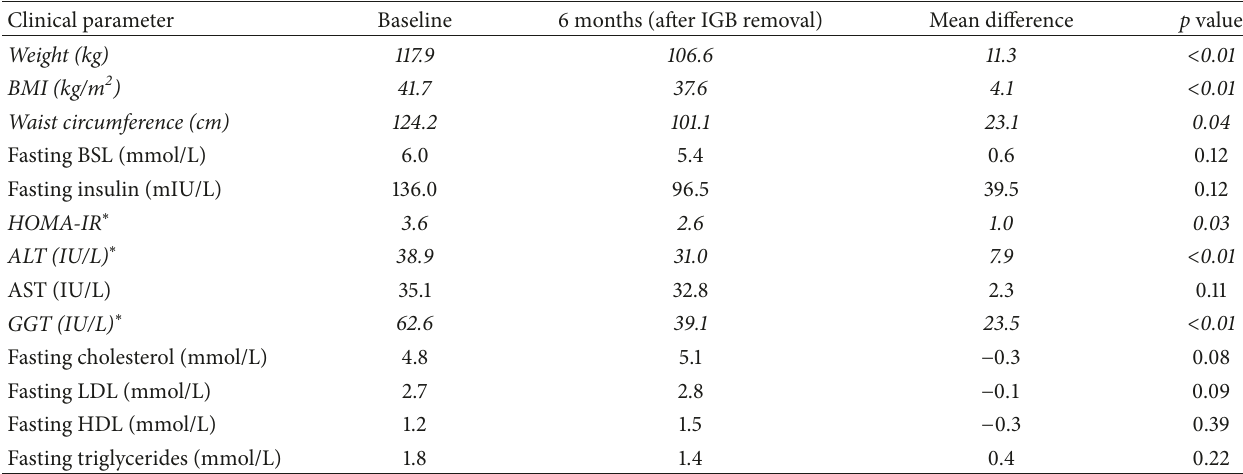
Table 2: Clinical outcomes at 6 months.